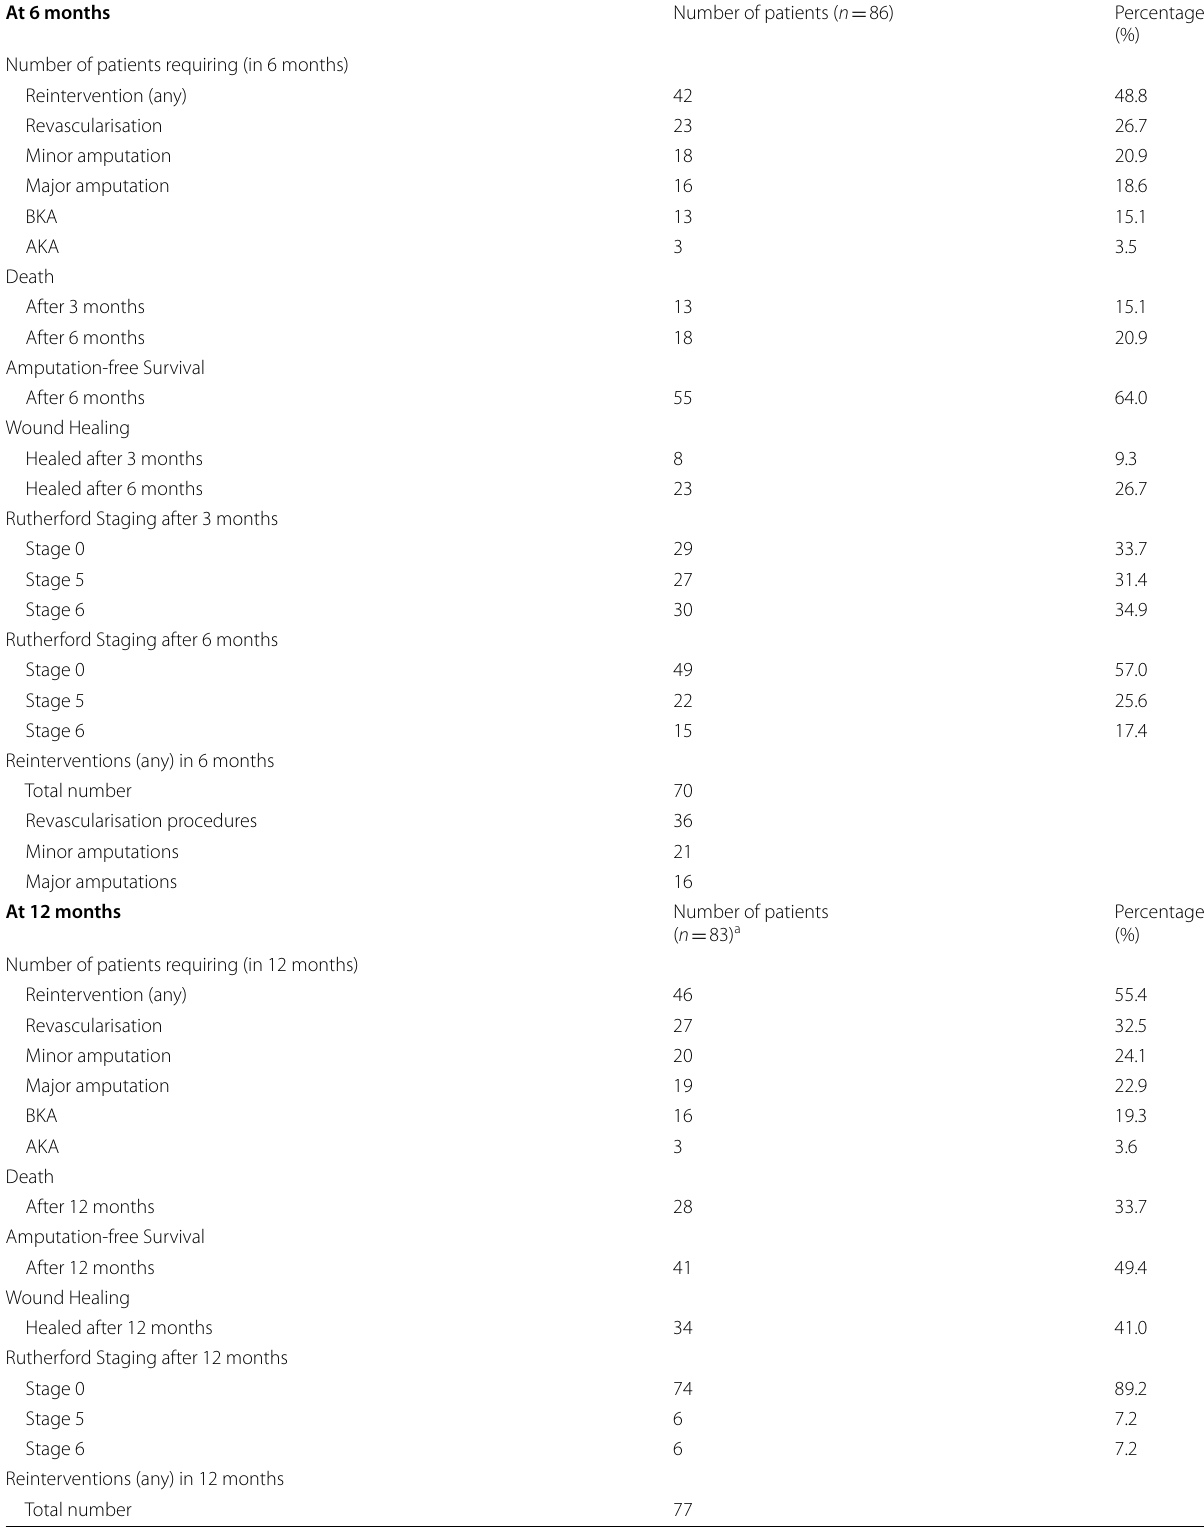
Table 3 Post-intervention Outcomes at 6 and 12 Months At 6